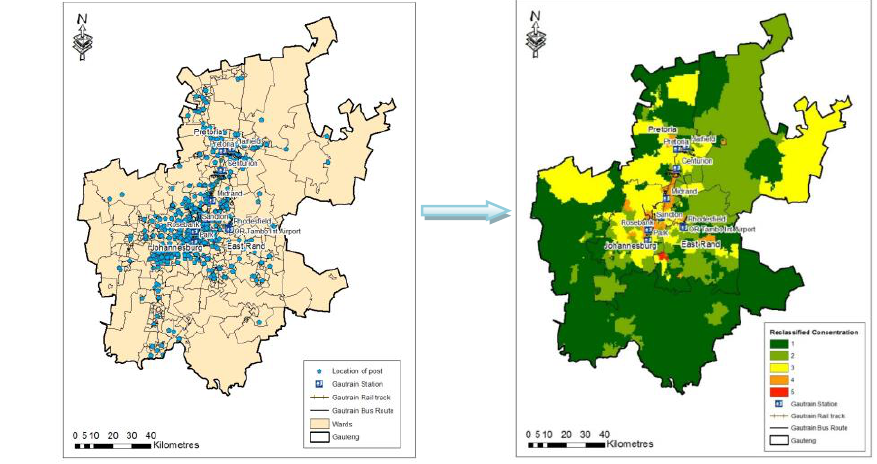
Figure 8: Gauteng wards and Focal statistics for wards